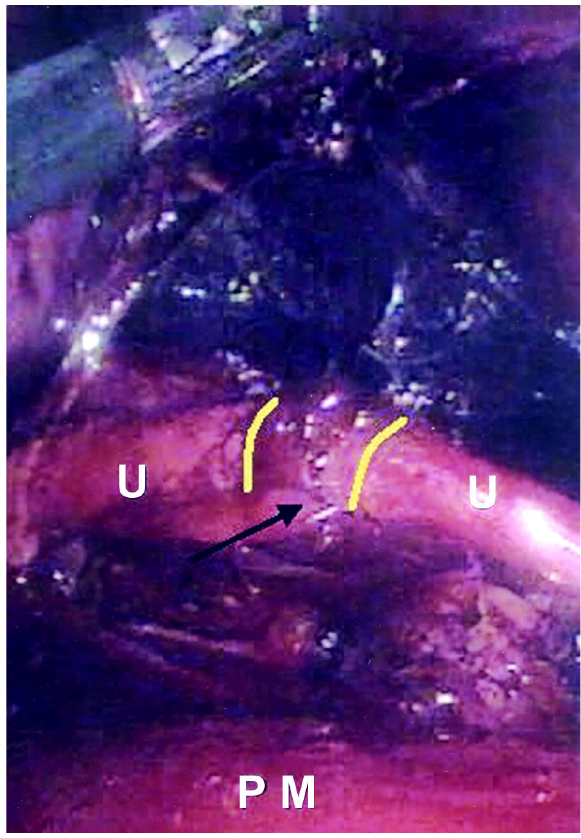
Figure 3 – Retroperitoneoscopic aspect of the re-anastomosed ureter (between yellow lines) (U - ureter; PM – psoas muscle).